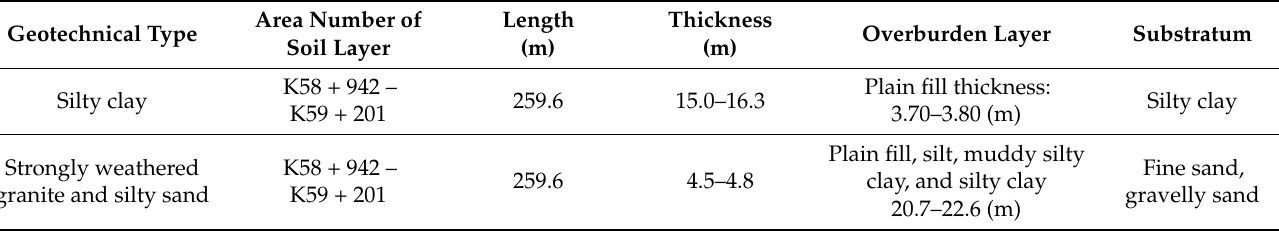
Table 1. Characteristics of soil (section A2 of coastal highway).